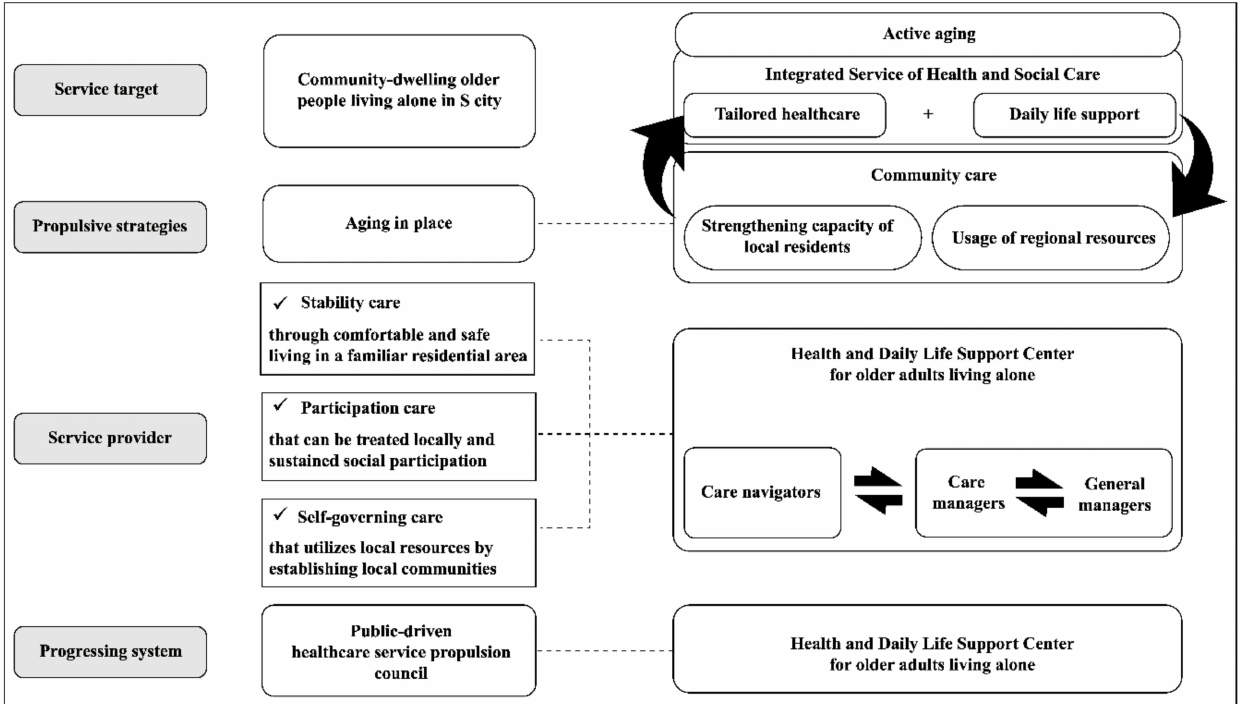
Figure 1. Overview of the community-based integrated service